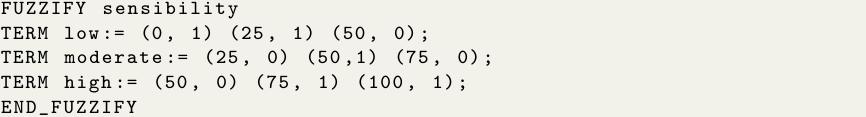
Code 1: Configuration example of the sensitivity sets using FCL.